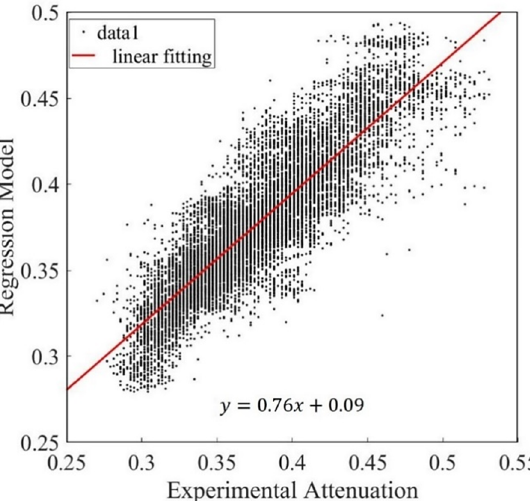
Figure 3. Experimental results versus the corresponding from the experimental model of Equation